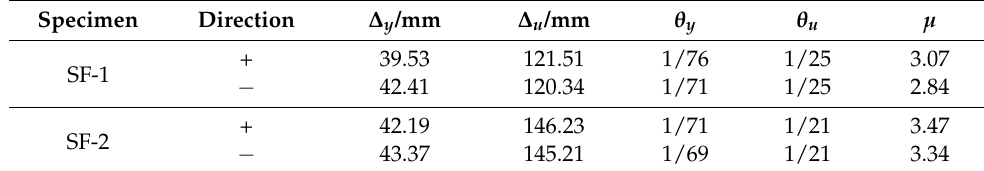
Table 5. Ductility coefficients of specimens SF-1 and